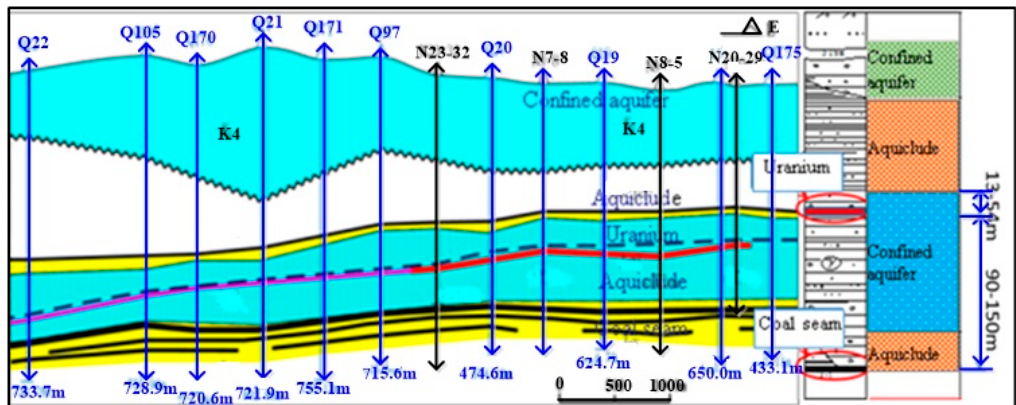
Figure 1. Hydrogeology of the stack resources of coal and uranium.